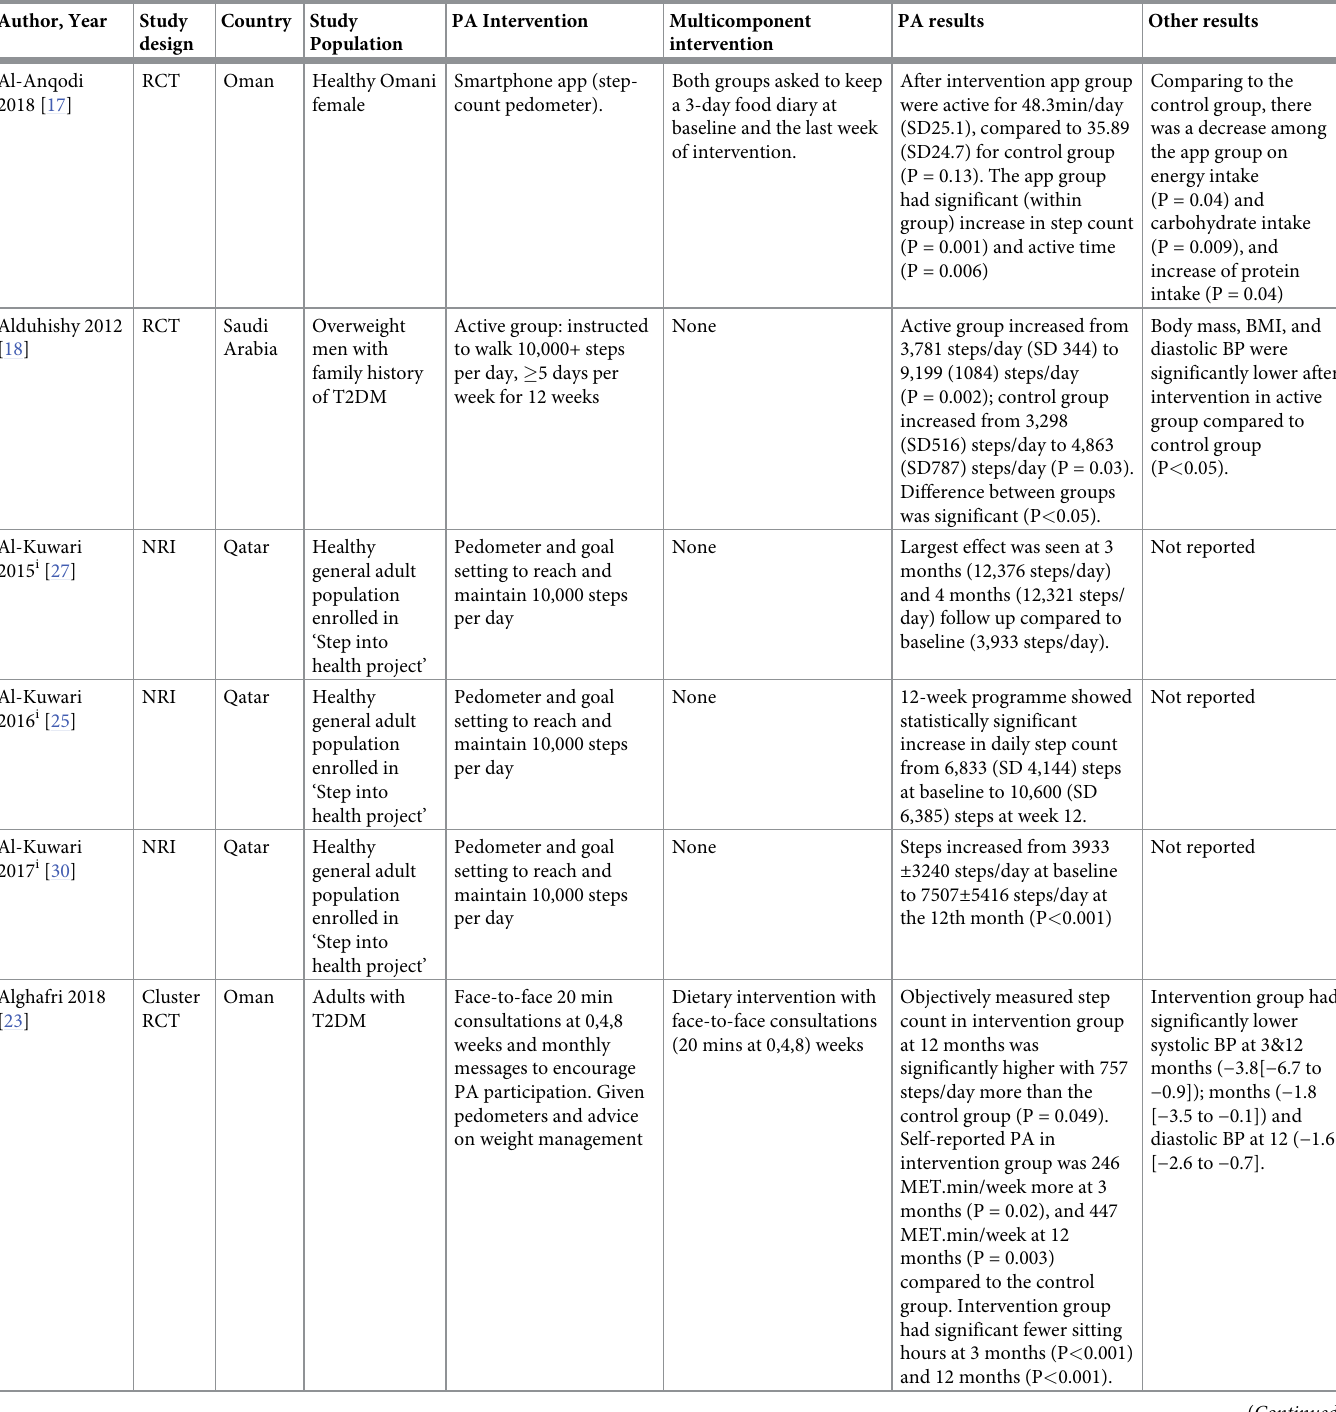
Table 3. Table of results for included